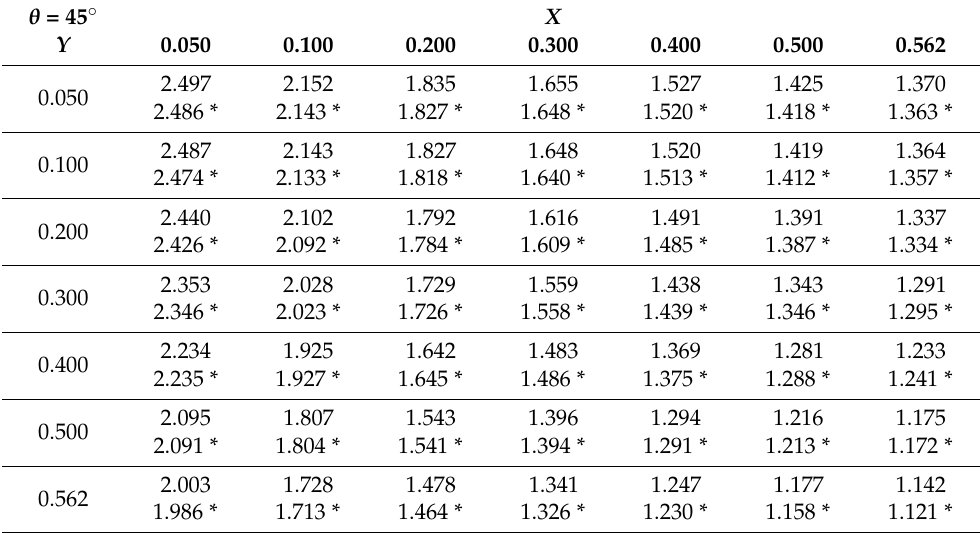
Table 4. Comparison of K ts values calculated using Equation (A3) (*) to the corresponding FEM results for various X and Y , while T / a = 1 and θ = 45 ◦